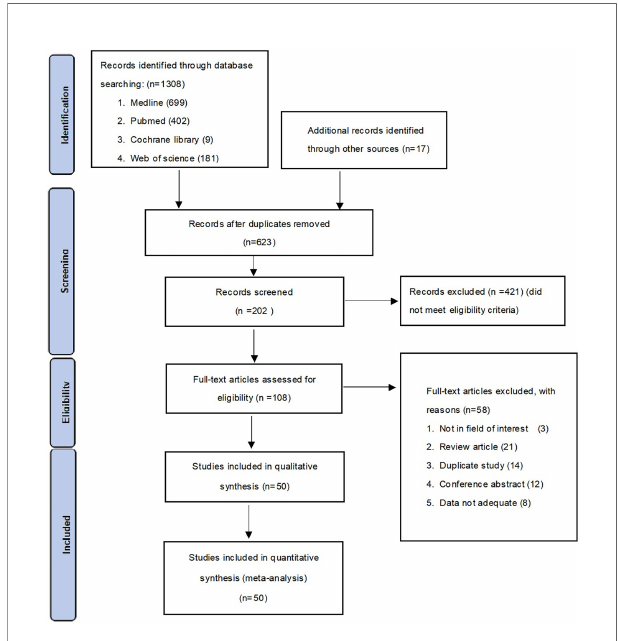
FIGURE 1 | Flow diagram of studies